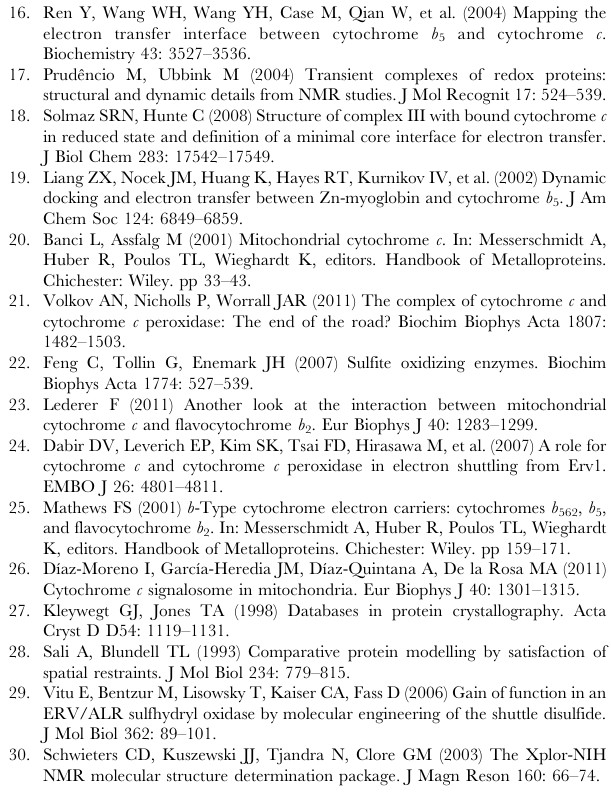
complexes colored by the heme-heme distances and the corresponding ET rates. See the legend to Figure S1 for details.